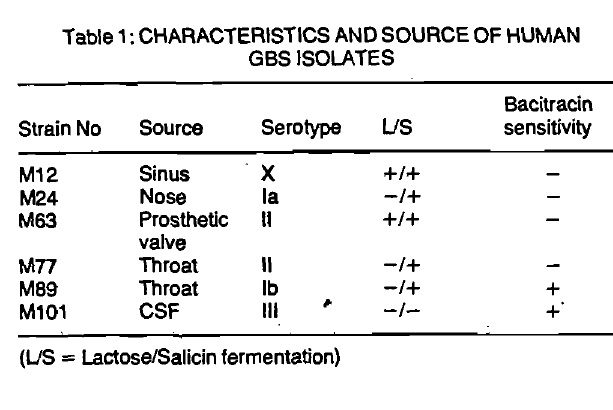
Table 1: CHARACTERISTICS AND SOURCE OF HUMAN GBS ISOLATES Strain